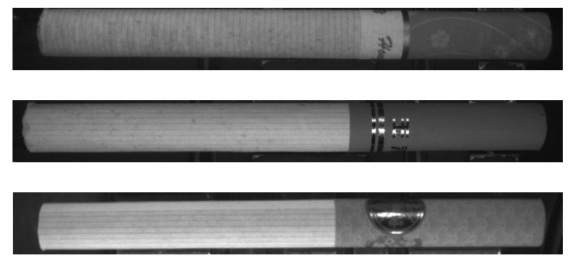
Figure 7. Normal cigarette image.